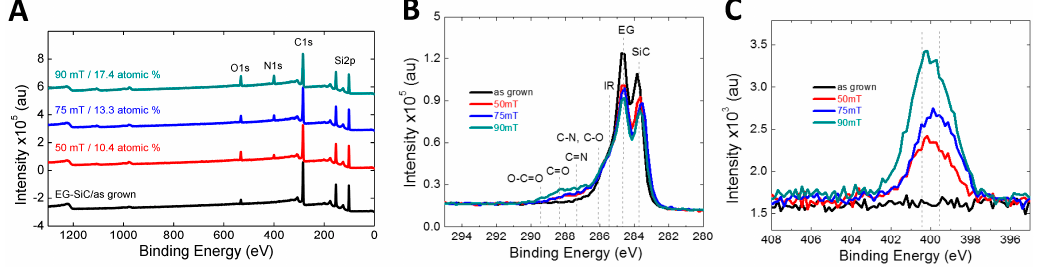
Figure 2. XPS of unmodified, and nitrogen modified graphene, depicting the ( A ) survey spectra; ( B ) the high resolution C1s spectra and ( C ) the high resolution N1s spectra. The dotted vertical lines represent approximate peak positions.